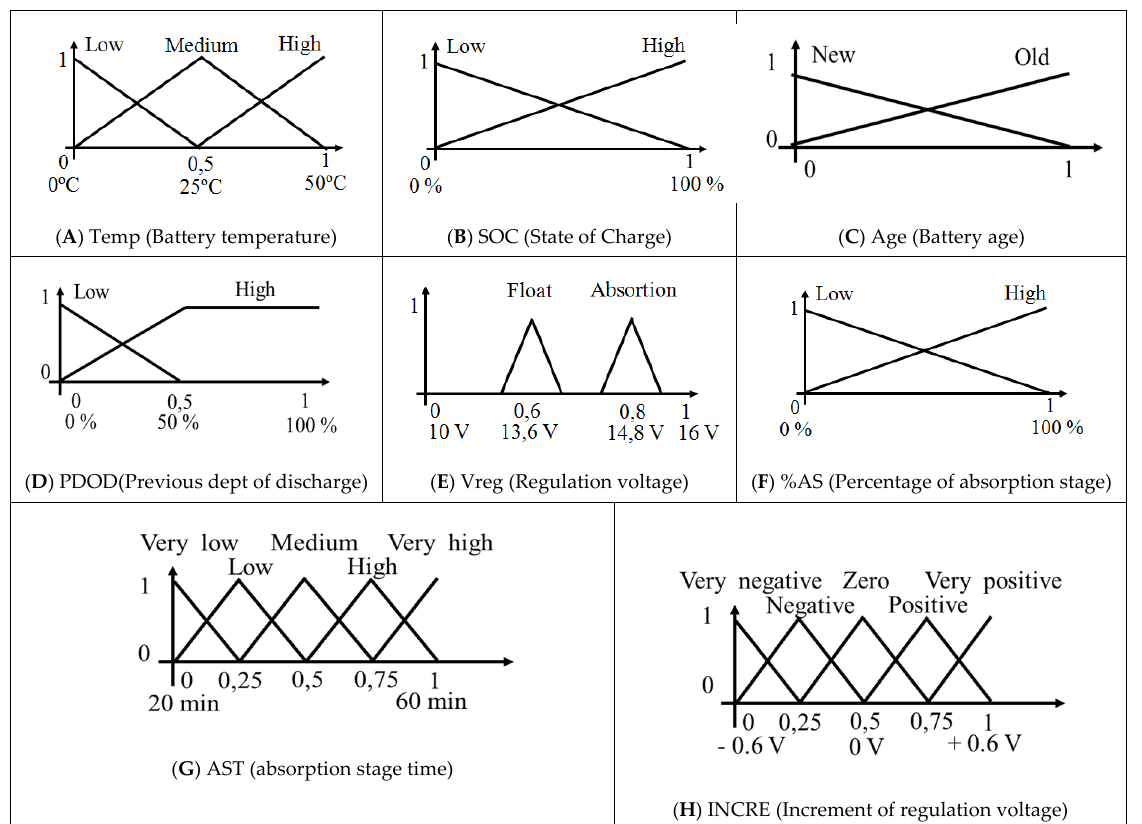
Figure 6. Membership functions defined in each variable.